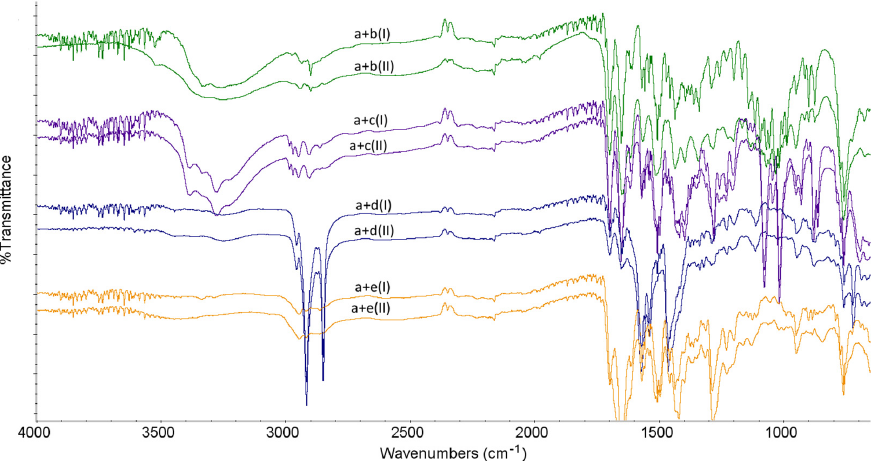
Figure 6 . FT-IR spectra for binary mixtures of linagliptin (a) with lactose (b), mannitol (c), magne- sium stearate (d) and polyvinylpyrrolidone (e) in the non-stressed (I) and stressed (II) samples.